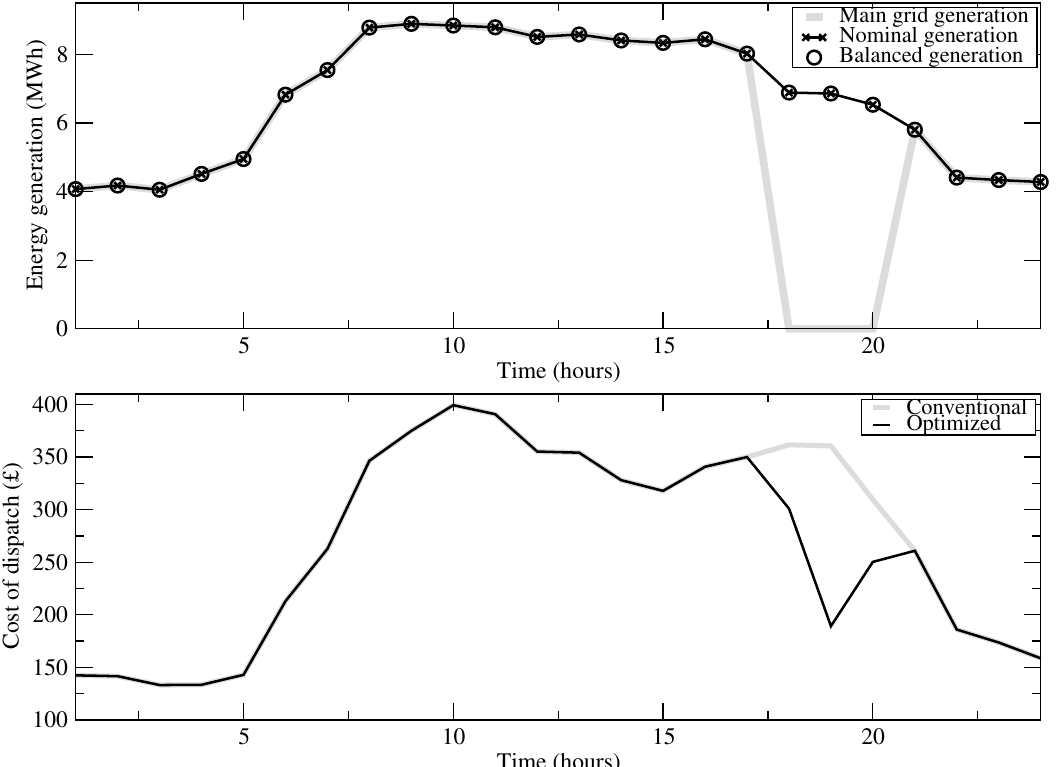
Figure 3. Top panel: resultant energy generation distribution and its balanced/optimized generation for normal operation; bottom panel: cost of operation between the conventional and optimized